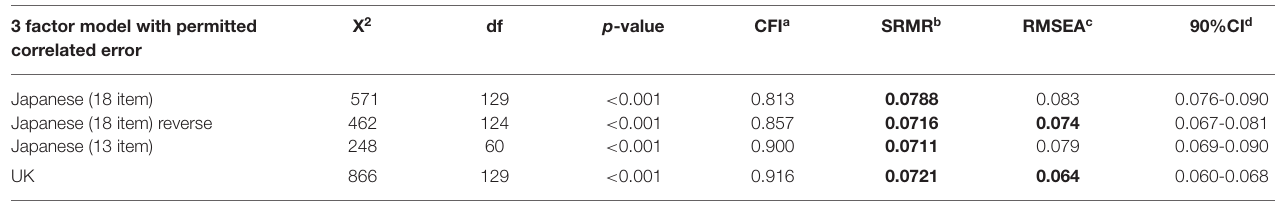
TABLE 2 | Fit Indices for Japanese 3-factor model with correlated error permitted. UK sample (Williams and Cameron, 2017) shown for comparison. 3 factor model with permitted correlated